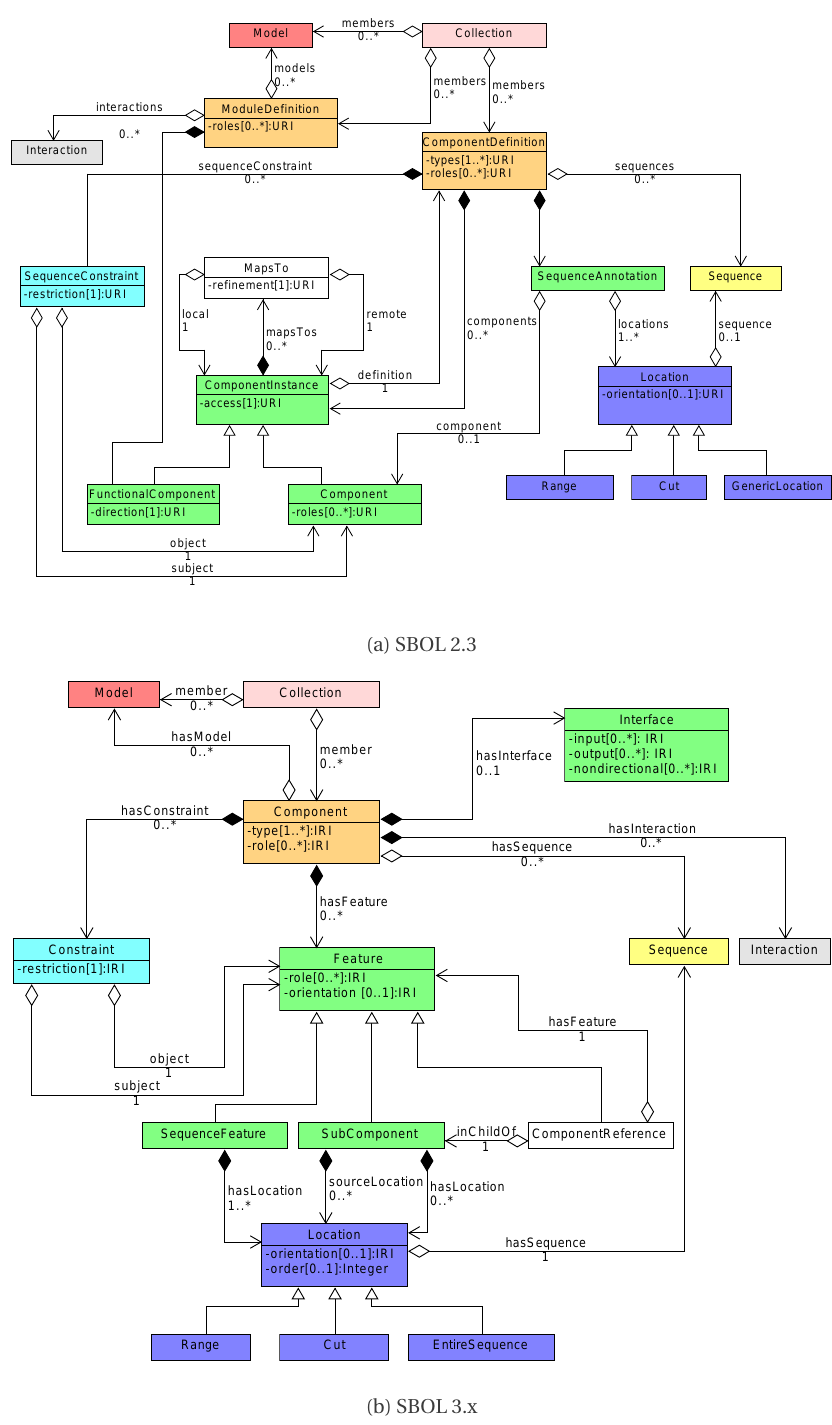
Figure 26: The mapping from the SBOL 2.3 data model to the SBOL 3.x data model, indicating corresponding classes/properties by color.